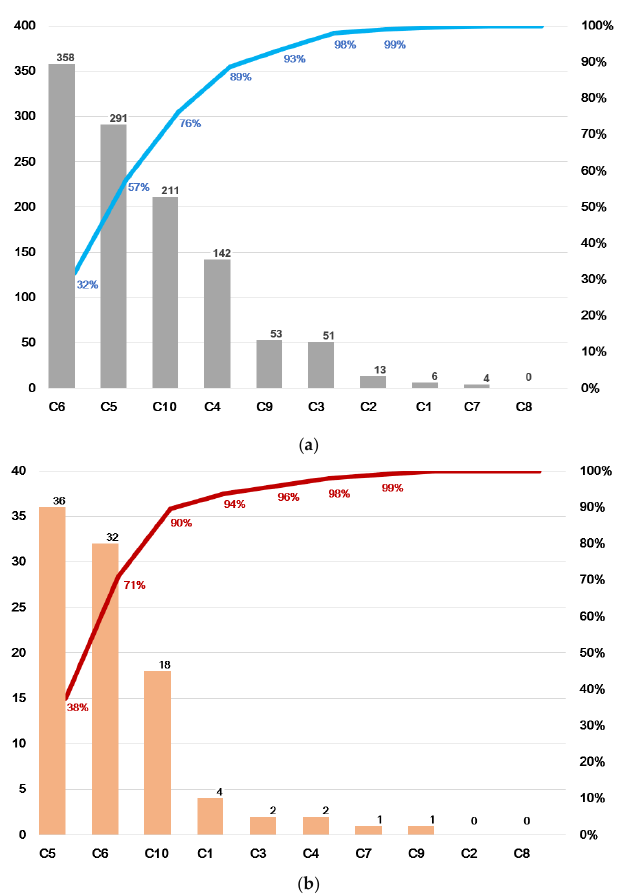
Figure 2. Pareto chart of the frequency of incidents according to WHO categorization. ( a ) Total PS incidents. ( b ) Adverse events. WHO 10-categories: C1: falls and other accidents; C2: patient behav-